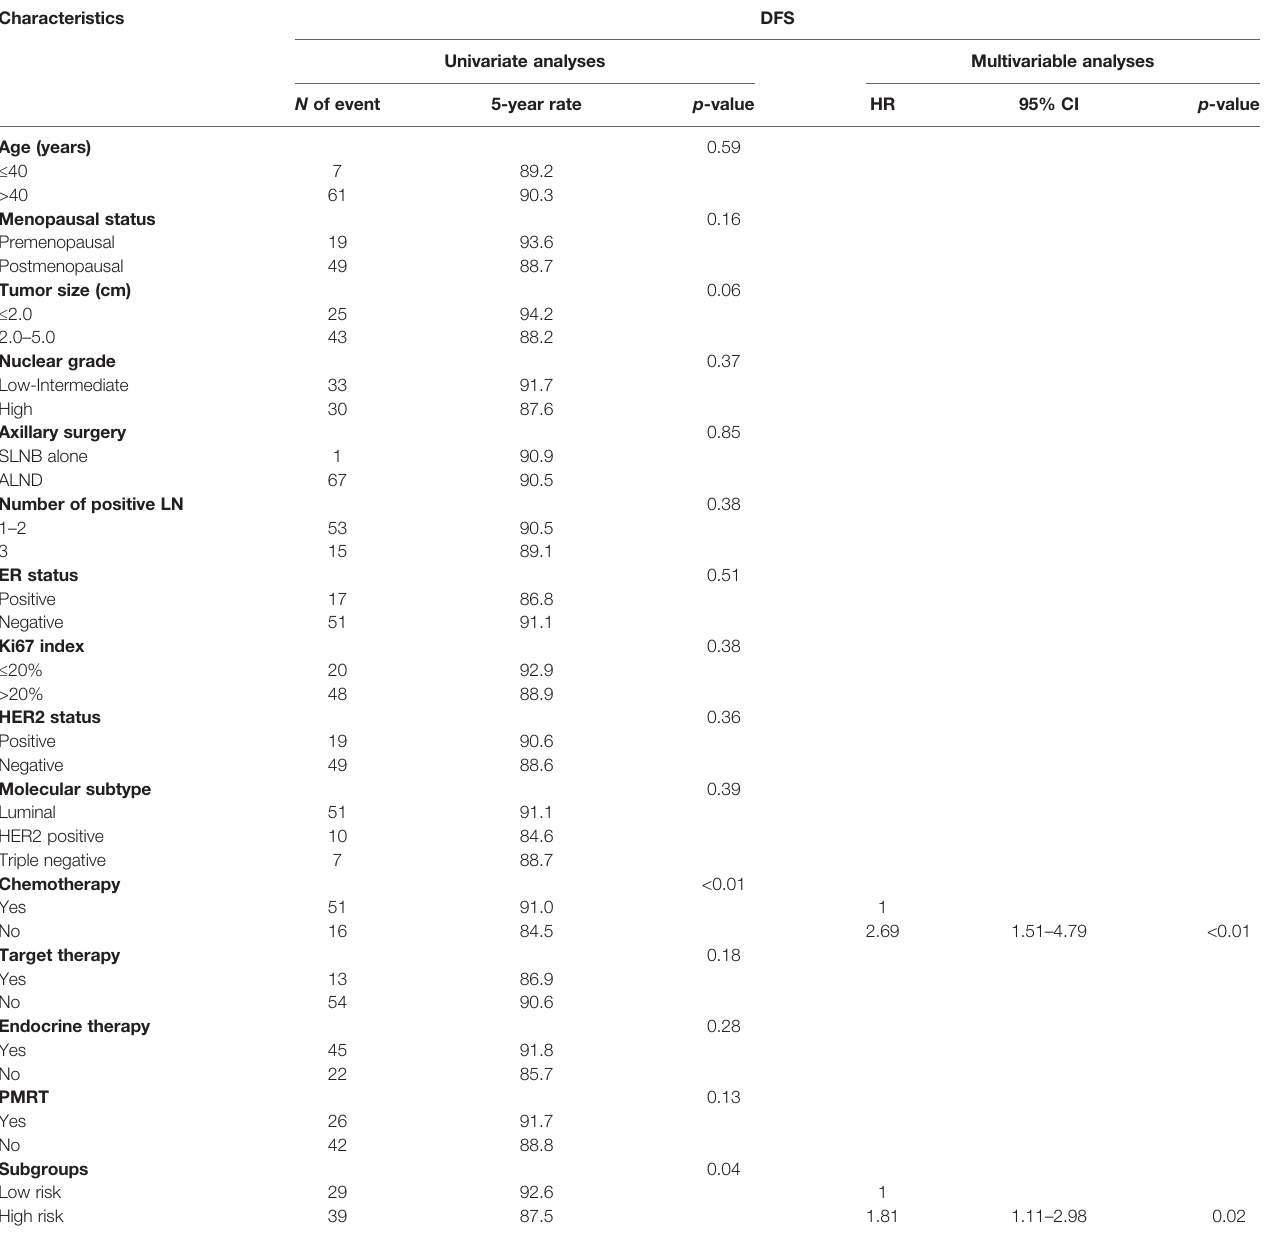
TABLE 2 | The univariate and multivariable analyses for outcomes.